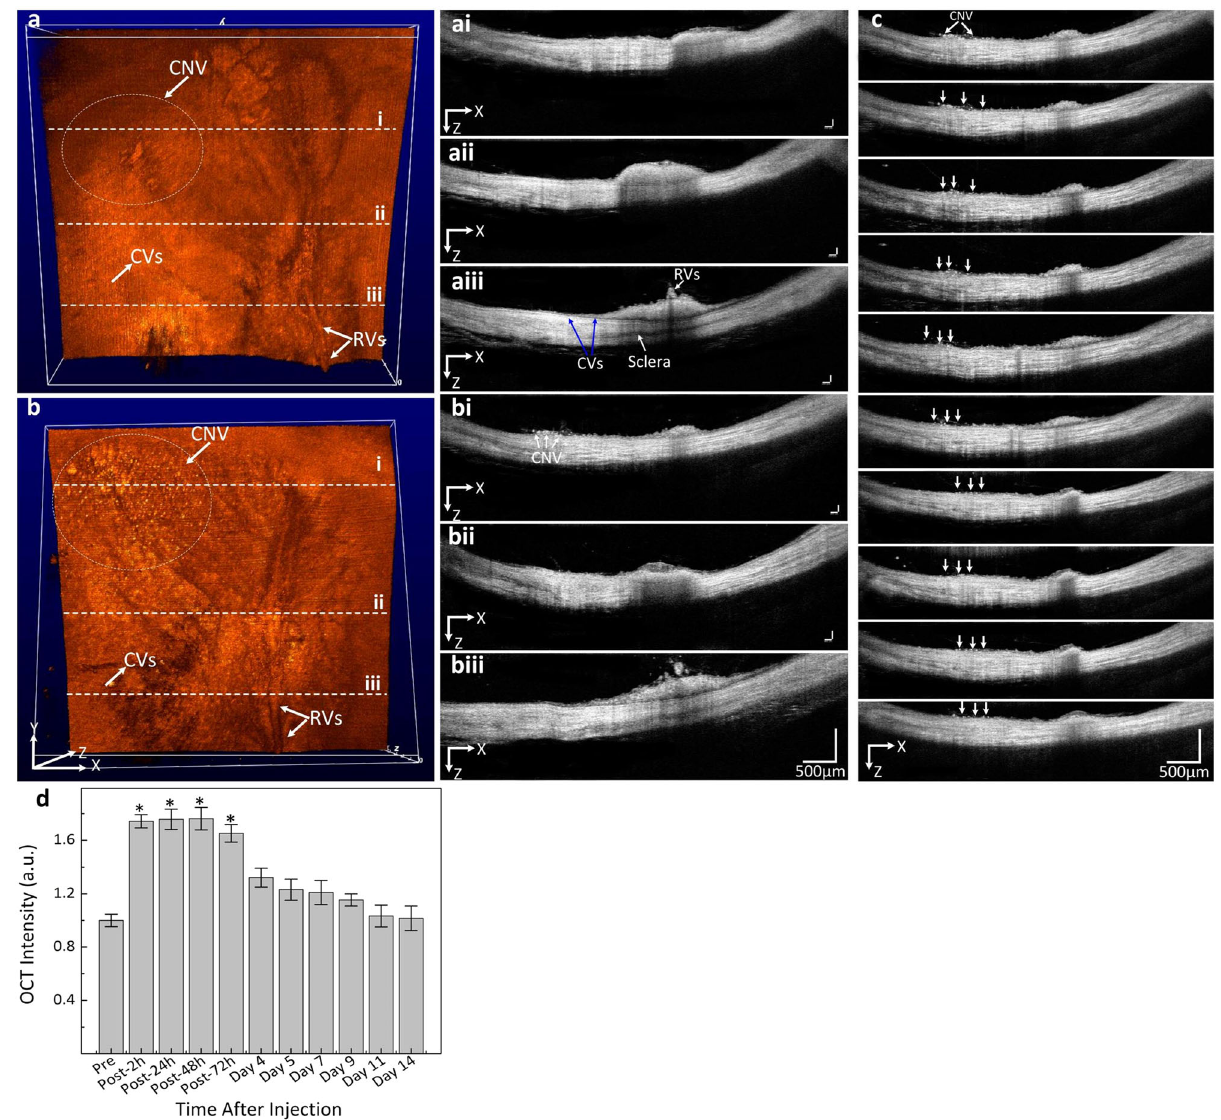
Fig. 6 In vivo contrast enhancement of OCT images of CNV in rabbits. a , b 3D OCT images before and after the injection of CGNP clusters-RGD. ai – aiii , bi – biii B-scan OCT images of one vertical slice (white dotted lines) through the retina. The distribution of CGNP clusters-RGD were clearly observed on 3D OCT image after injection (white dotted circle). c Cross-sectional B-scan OCT images obtained at different time points after the administration of CGNP clusters-RGD (2 h, 24 h, 48 h, 73 h, days 4, 5, 7, 9, 11, and 14). White arrows show the position of CNV. Rabbit injected with CGNP clusters-RGD show signi fi cant enhancement of OCT signals. d The error bars in d represent the standard deviation of the mean OCT intensities ( N = 3). Source data are provided as a Source Data fi